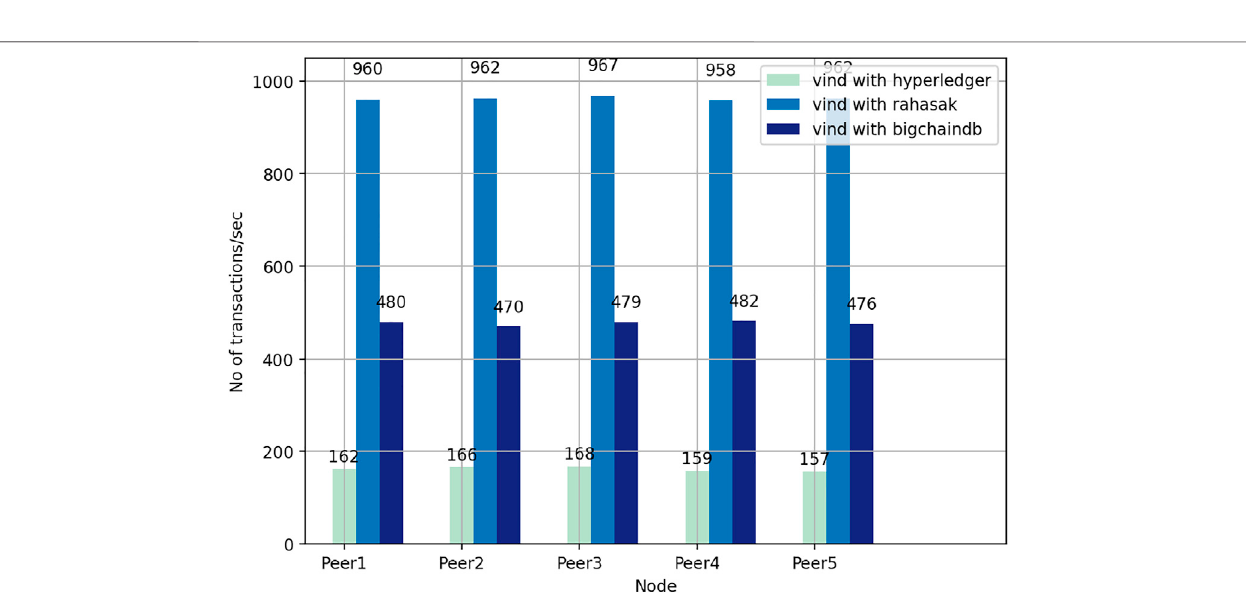
Frontiers in Blockchain |